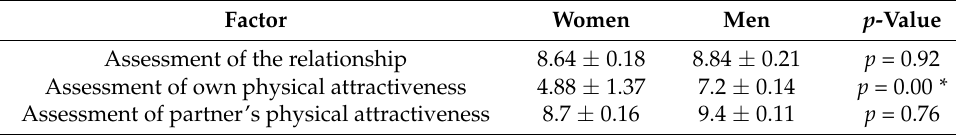
Table 3. Assessment of the relationship and physical attractiveness of the study